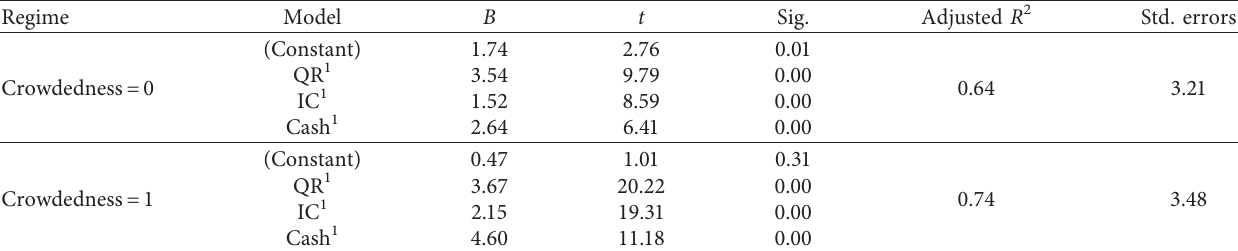
Table 3: Last-choice-based BST regression